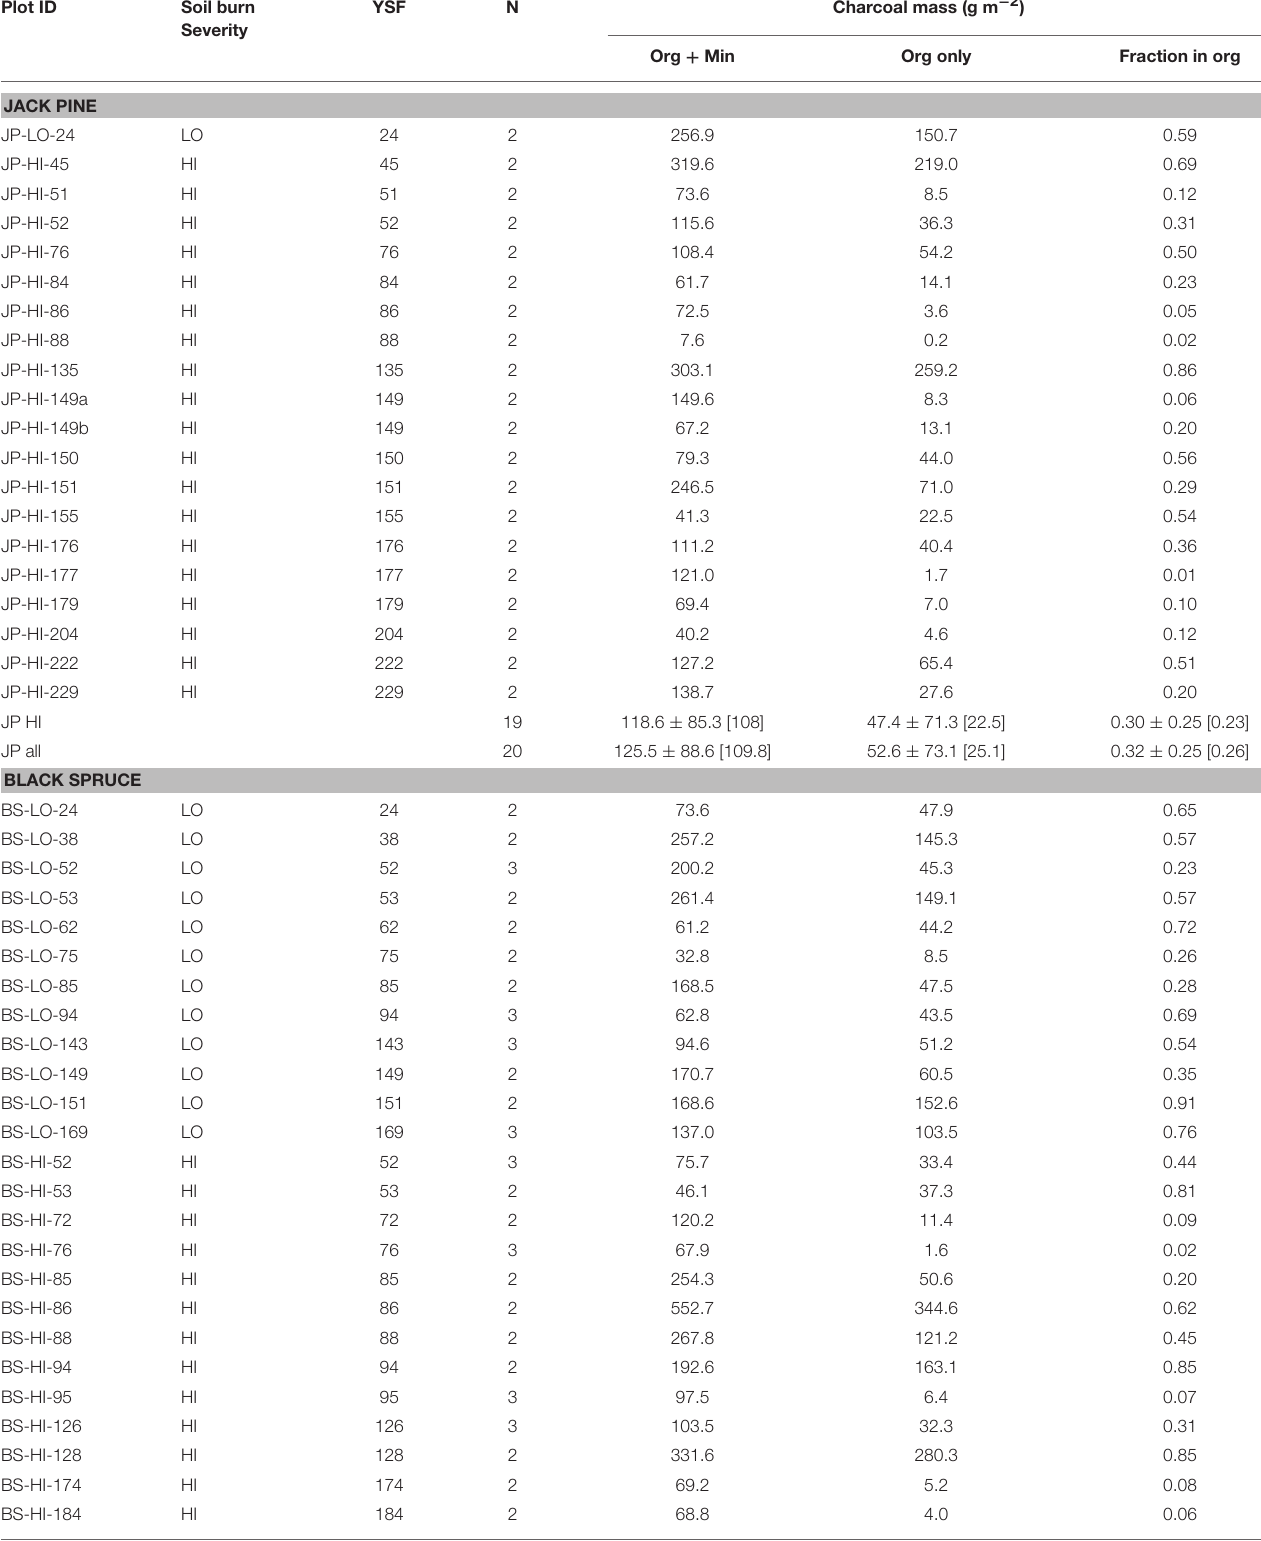
TABLE 1 | Characteristics of the chronosequence stands. Plot